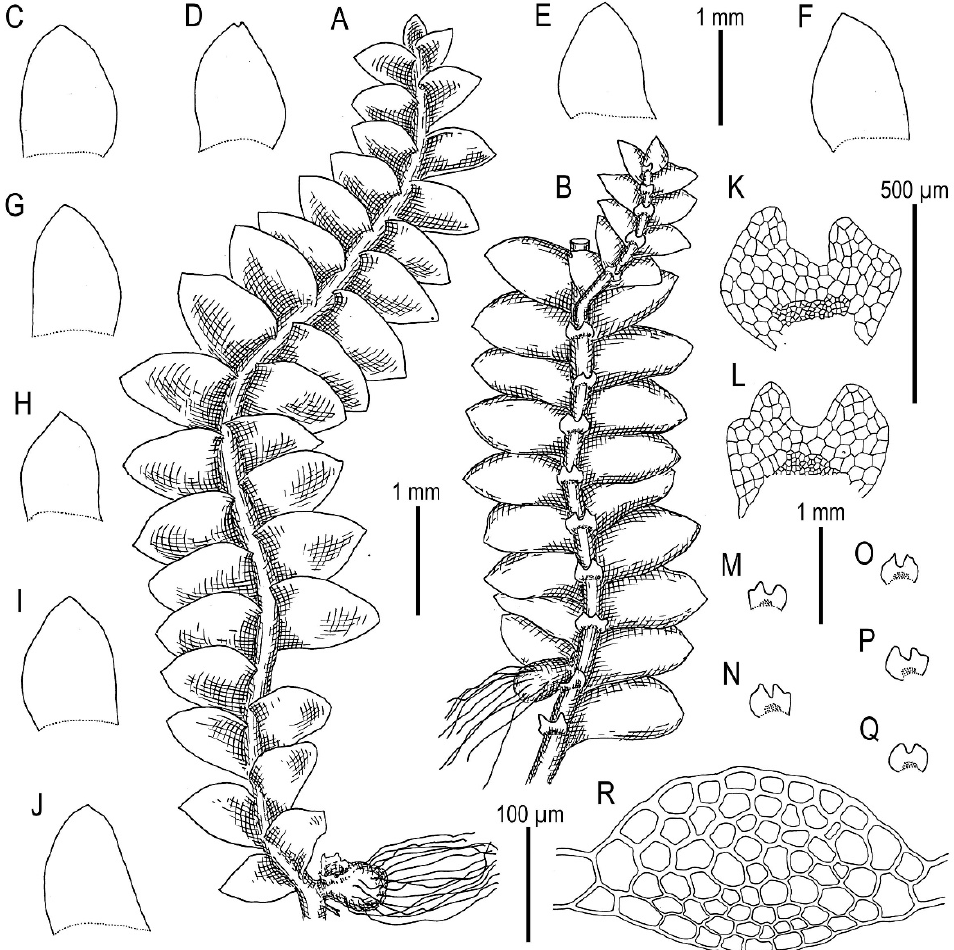
Figure 18. Calypogeia neogaea (R.M. Schust.) Bakalin: ( A ) Plant habit, fragment, dorsal view; ( B ) Plant habit, fragment, ventral view; ( C – J ) Leaves; ( K – Q ) Underleaves; ( R ) Stem cross section. All from US-41a-77-14 (VBGI).